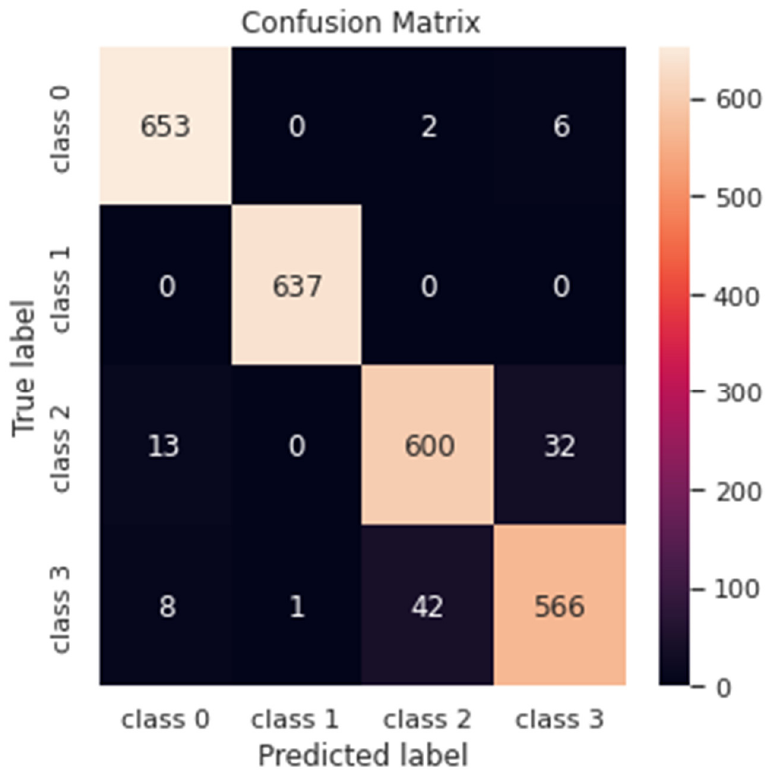
Figure 11. Confusion matrix of the proposed model for multi-classification task.